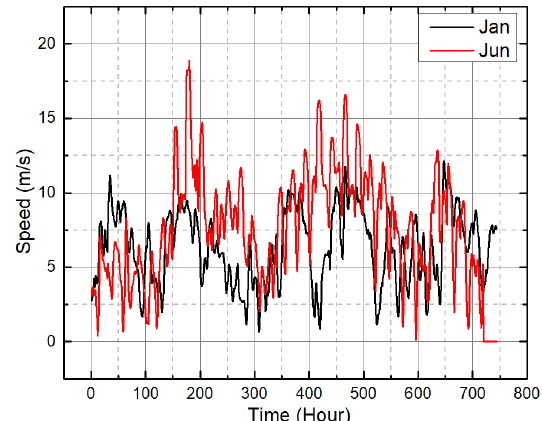
Figure 1. Wind speed measured at 50m height, Dhahran 2018.